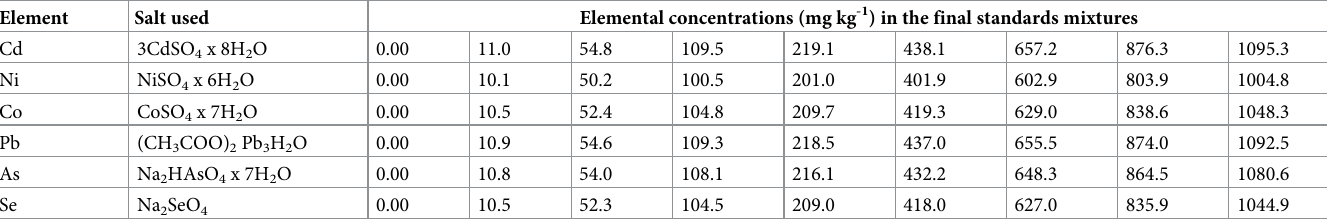
Table 3. Chemical salts used for spiking and actual concentrations in the amended fertilisers for each element. Element Salt used